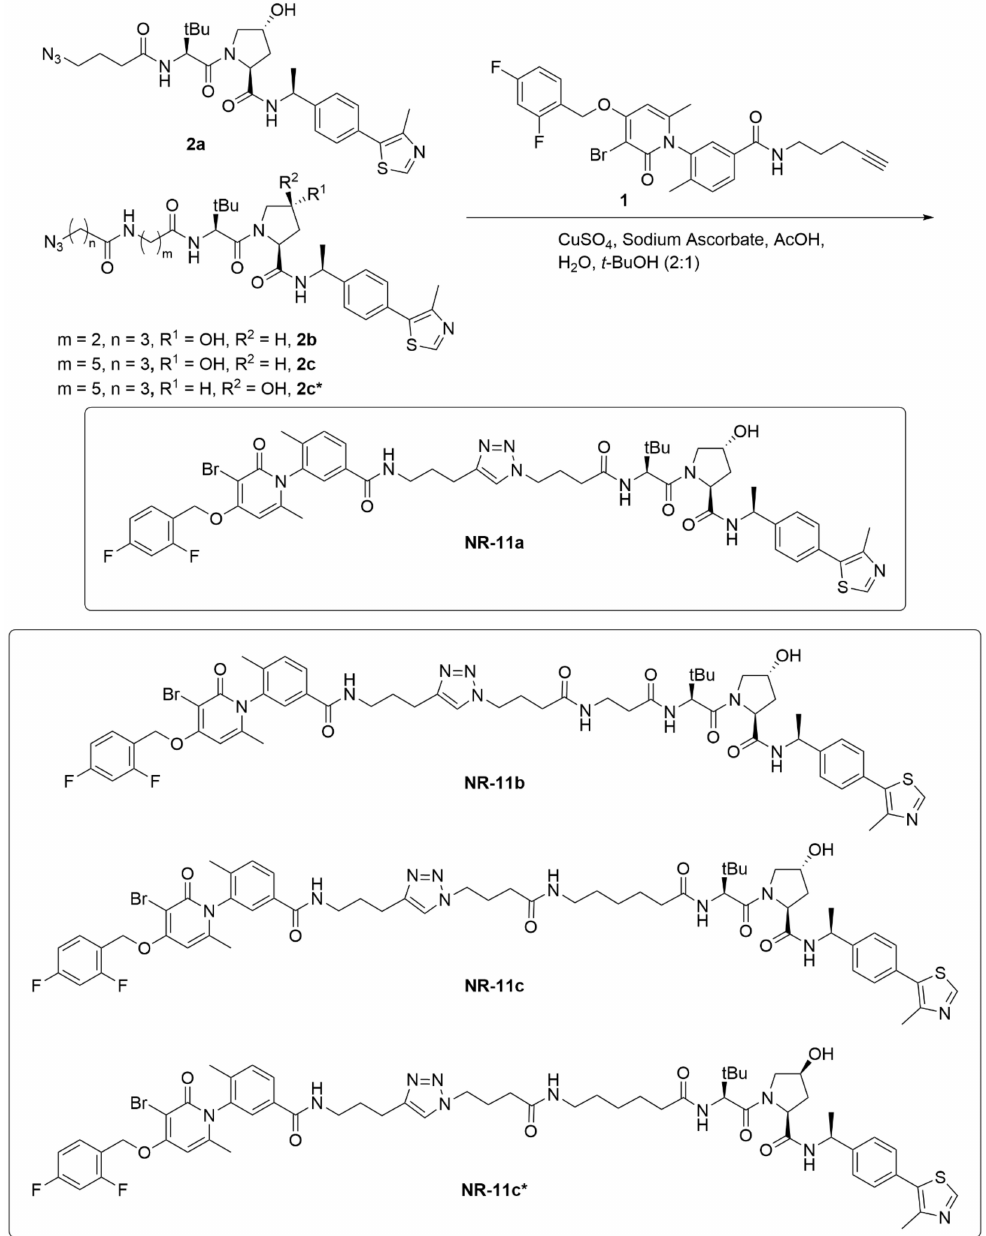
Figure 1. Synthesis of PROTACS NR-11a–c